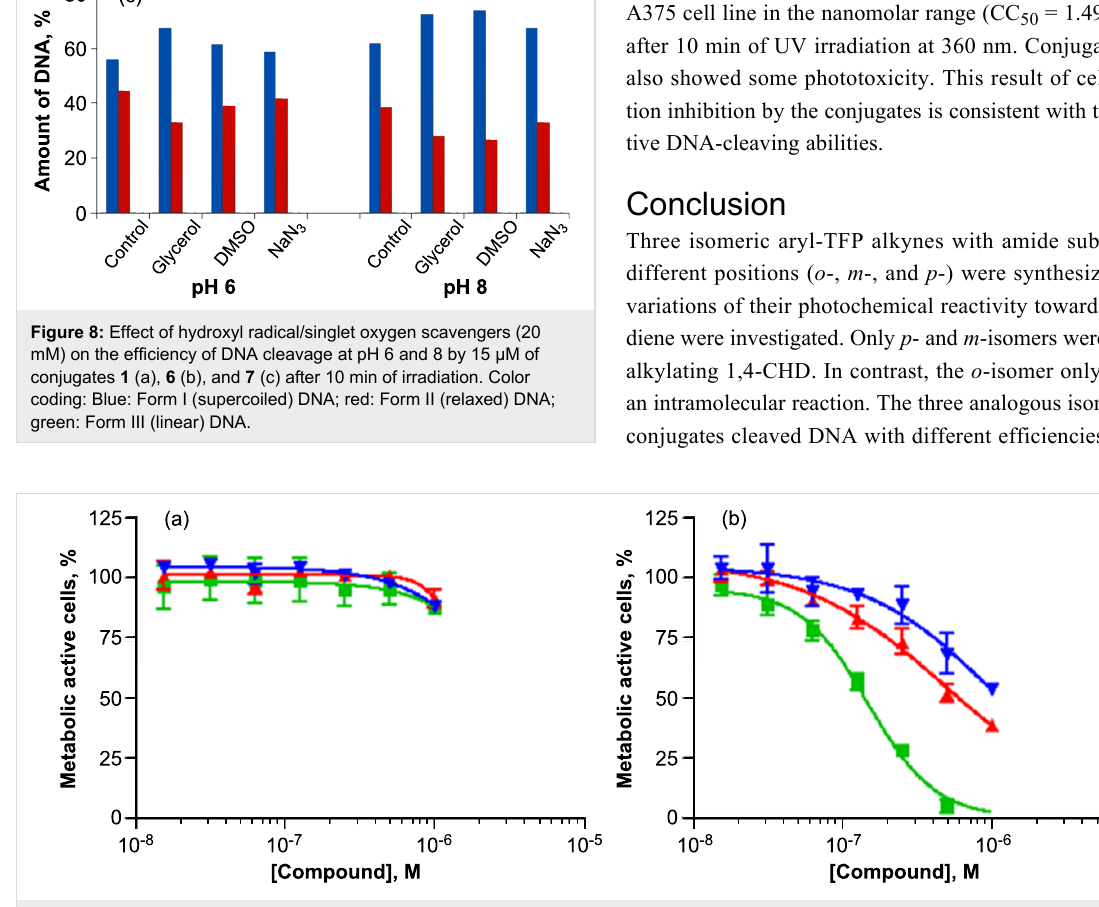
Figure 9: Cell proliferation assay using A375 cells (human melanoma) and compound 1 (green square), 6 (red up-pointing triangle), and 7 (blue down-pointing triangle) in dark (a) and after 10 min of UV (360 nm) irradiation.